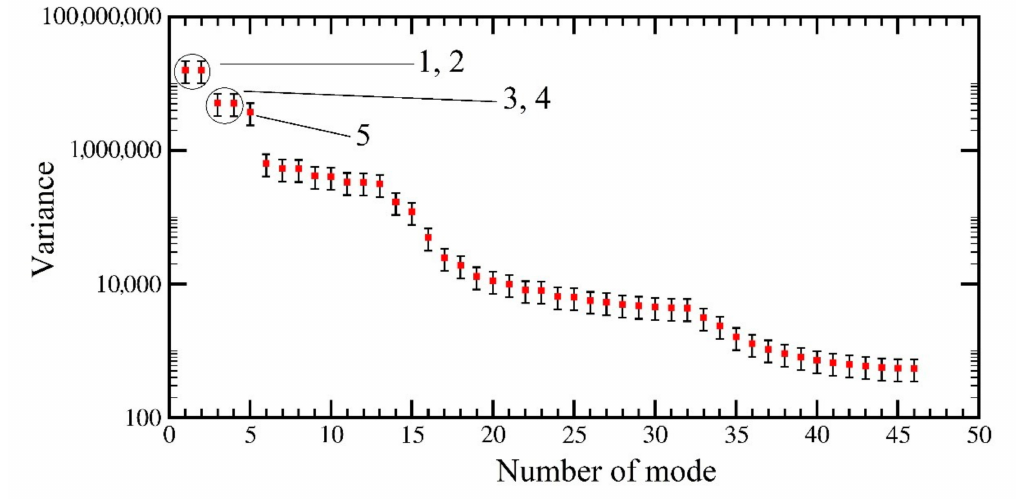
Figure 6. Singular values spectrum of data with window size of 46 image with five